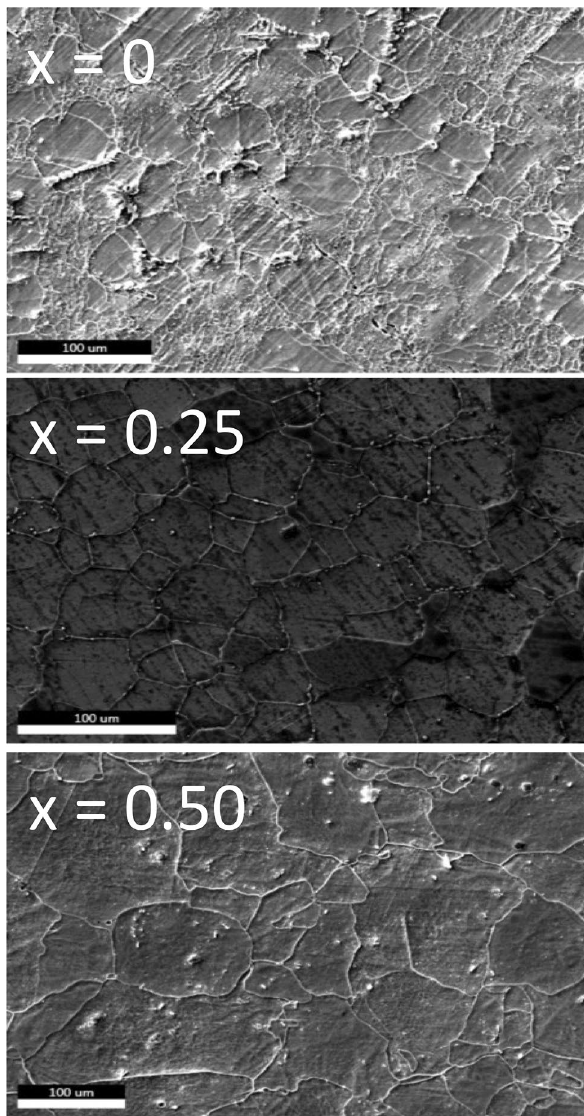
Fig. 6 SEM images in 100 μm frames for x = 0, x = 0.25, and x = 0.5 of Fe V Mn Ge Heusler alloys 2 1-x x